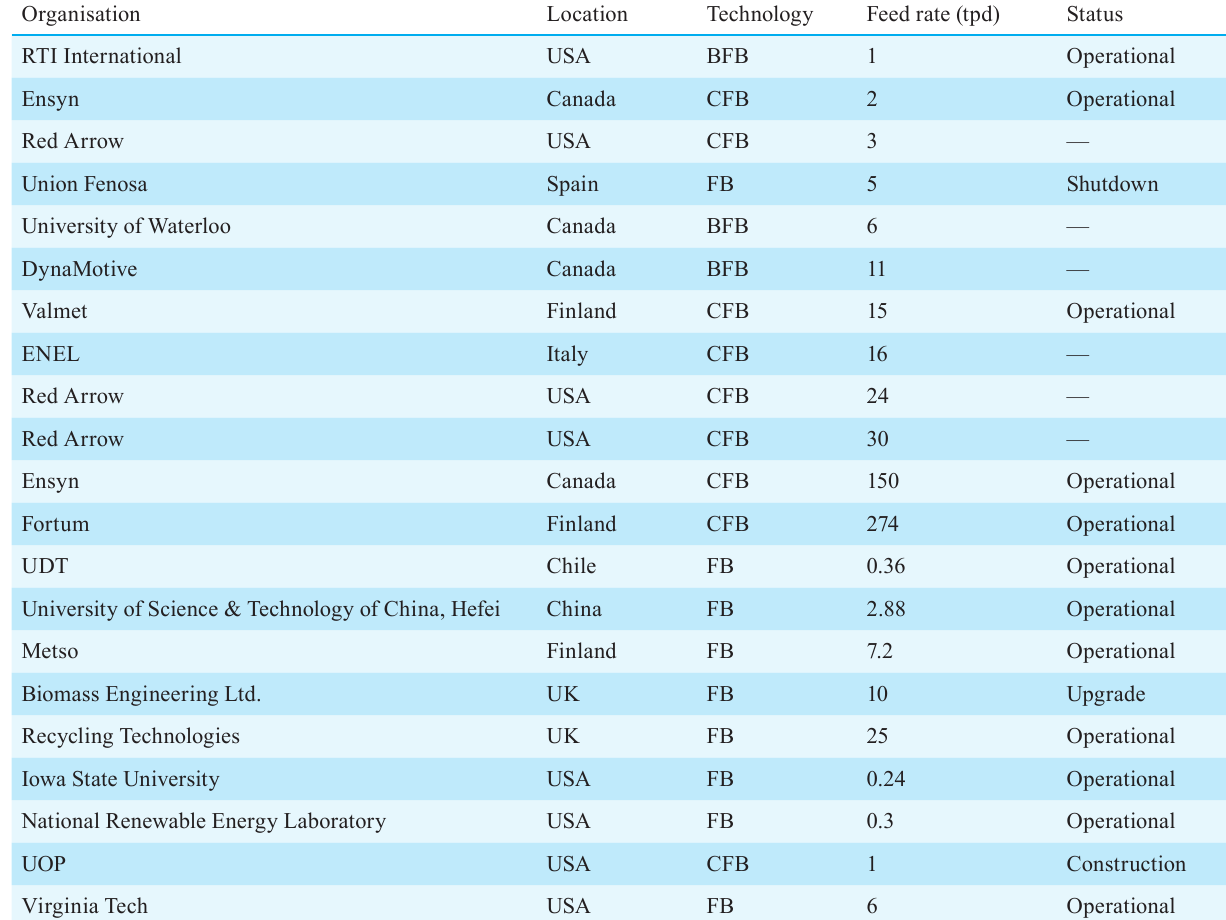
Table 3 Pyrolysis units worldwide using fluidised bed reactors. Source: Adapted from Dhyani and Bhaskar (2018) and Perkins, Bhaskar, and Konarova